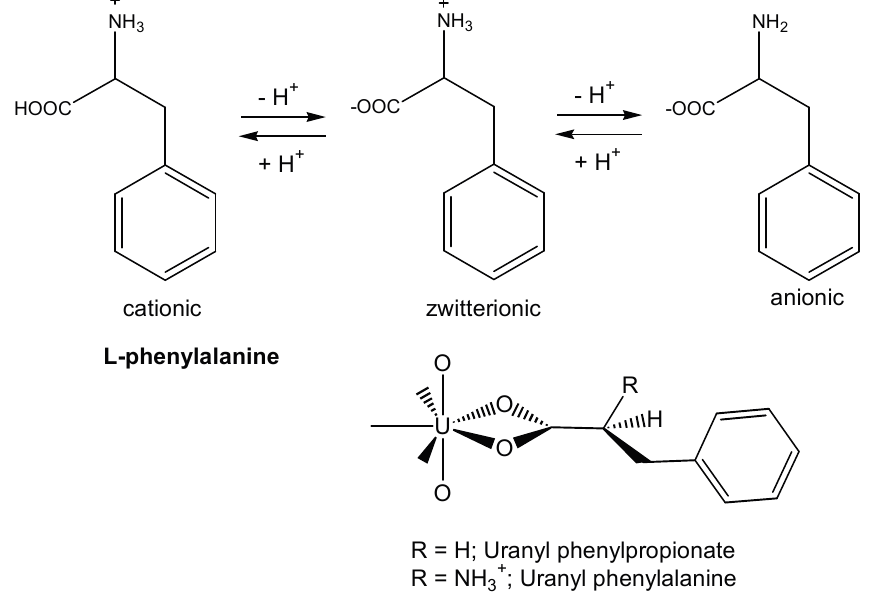
Figure 3. Chemical structures of the ionic forms of L -phenylalanine and of the proposed uranyl(VI)